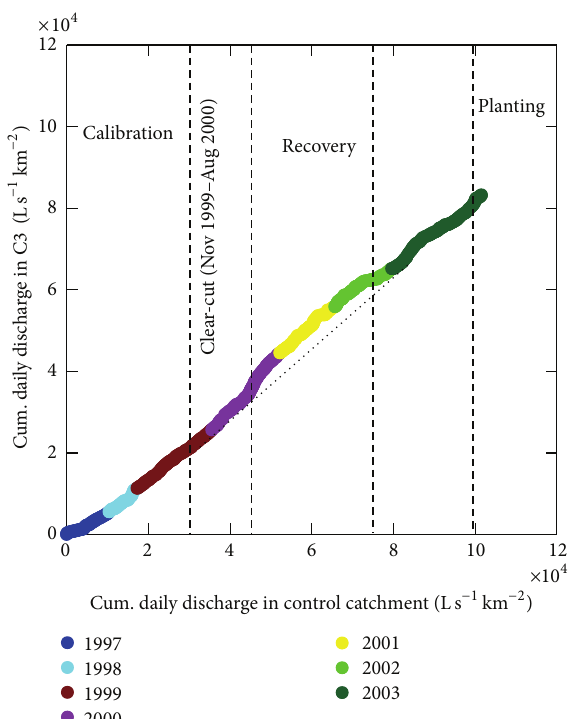
Figure 2: Changes in cumulative daily discharge between C1 and C3 which showed the effect of clear-cutting during the preparation of forest plantation in